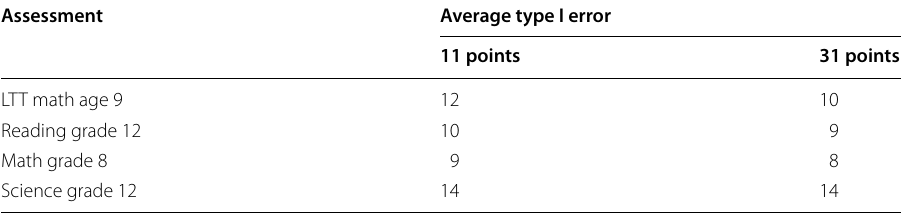
Table 1 Average Type I error for generalized residuals of item response